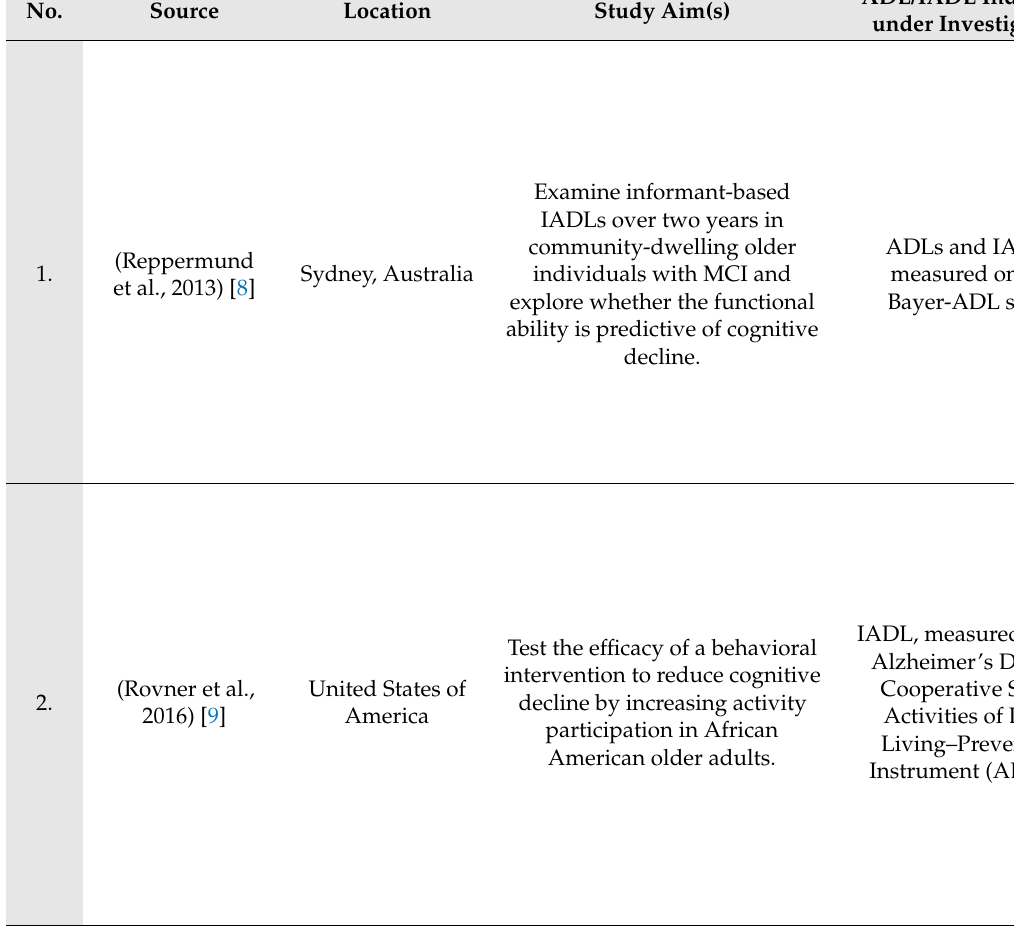
Table 3. Summary of the characteristics of the published articles included in the final analysis.